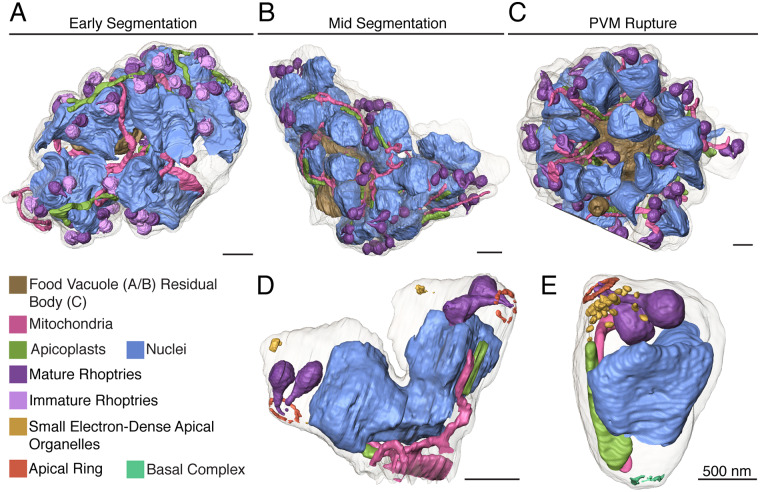
The whole schizont.A. In early segmentation, sets of rhoptries composed of one mature and one immature bulb are associated with 4n or 2n nuclei. The apicoplast and mitochondrion twist through the cell, undivided. B. At mid-segmentation, pairs of rhoptries are fully mature and nuclei are either 2n or 1n. Apicoplasts are divided and associated with the undivided mitochondrion. C. At PVM rupture, individual sets of rhoptries, nuclei, apicoplasts, and mitochondria are separated into their respective merozoite plasma membranes. Most merozoites are fully separated, but eight remain attached to the residual body. D. A mid-segmentation bud with material for two daughter cells. The mitochondrion snakes out of the rendered bud to connect with other budding cells. E. A fully segmented merozoite with a mature apical head, a segmented nucleus, apicoplast, mitochondrion, and the basal ring. Scale bars of renderings interpolated from structure sizes in EM data.